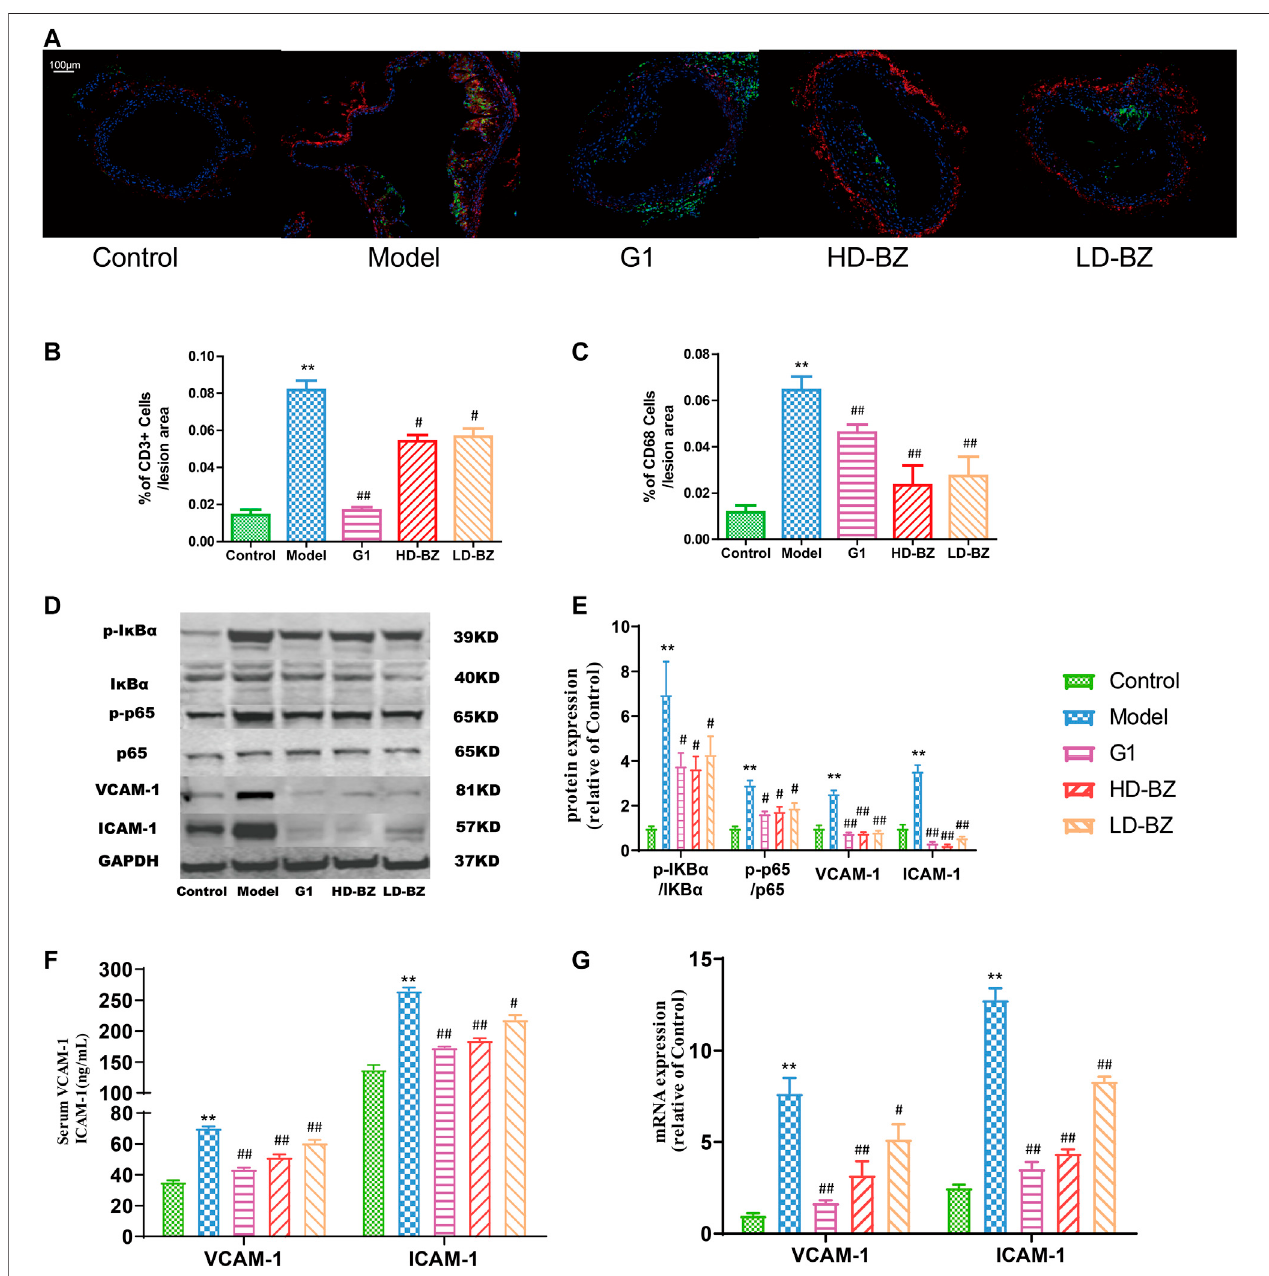
FIGURE 2 | Effect of BZBS on the accumulation of in fl ammatory cells and adhesion molecule expression mediated by transactivation of NF- κ B signalling in Ovx/ ApoE - /-mice. (A) Immuno fl uorescence was used to quantify CD68 + cells (macrophages, green) and CD3 + cells (T cells, red) in the aortic arch. (B) %of CD3 + cells/lesion area. (C) %of CD68 + cells/lesion area. (D) Western blots of phospho-I κ B α (Ser36), I κ B α , phospho-p65, p65, VCAM-1, ICAM-1, and GAPDH. (E) Graph showing quanti fi cation results of the bands in D, using GAPDH as an internal reference protein. (F) Graph showing the levels of VCAM-1 and ICAM-1 as determined by ELISA. (G) Graph showing the levels of VCAM-1 and ICAM-1 mRNA as determined by quantitative real-time PCR analysis; GAPDH was used as an internal reference gene. ** p < 0.01 vs. the control group; # p < 0.05, ## p < 0.01 vs. the model group ( n (cid:1) 4 – 6).